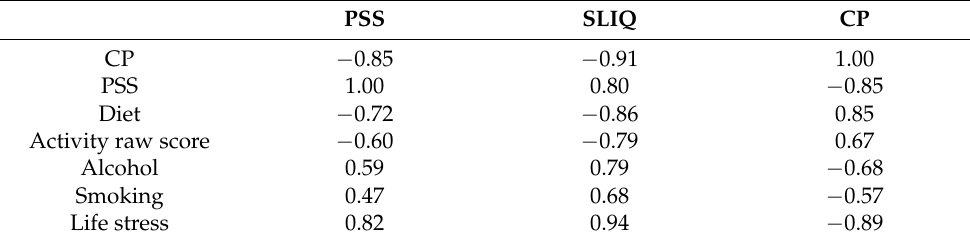
Table 5. Cross-loadings between stress, concentration performance, and lifestyle among participants during the